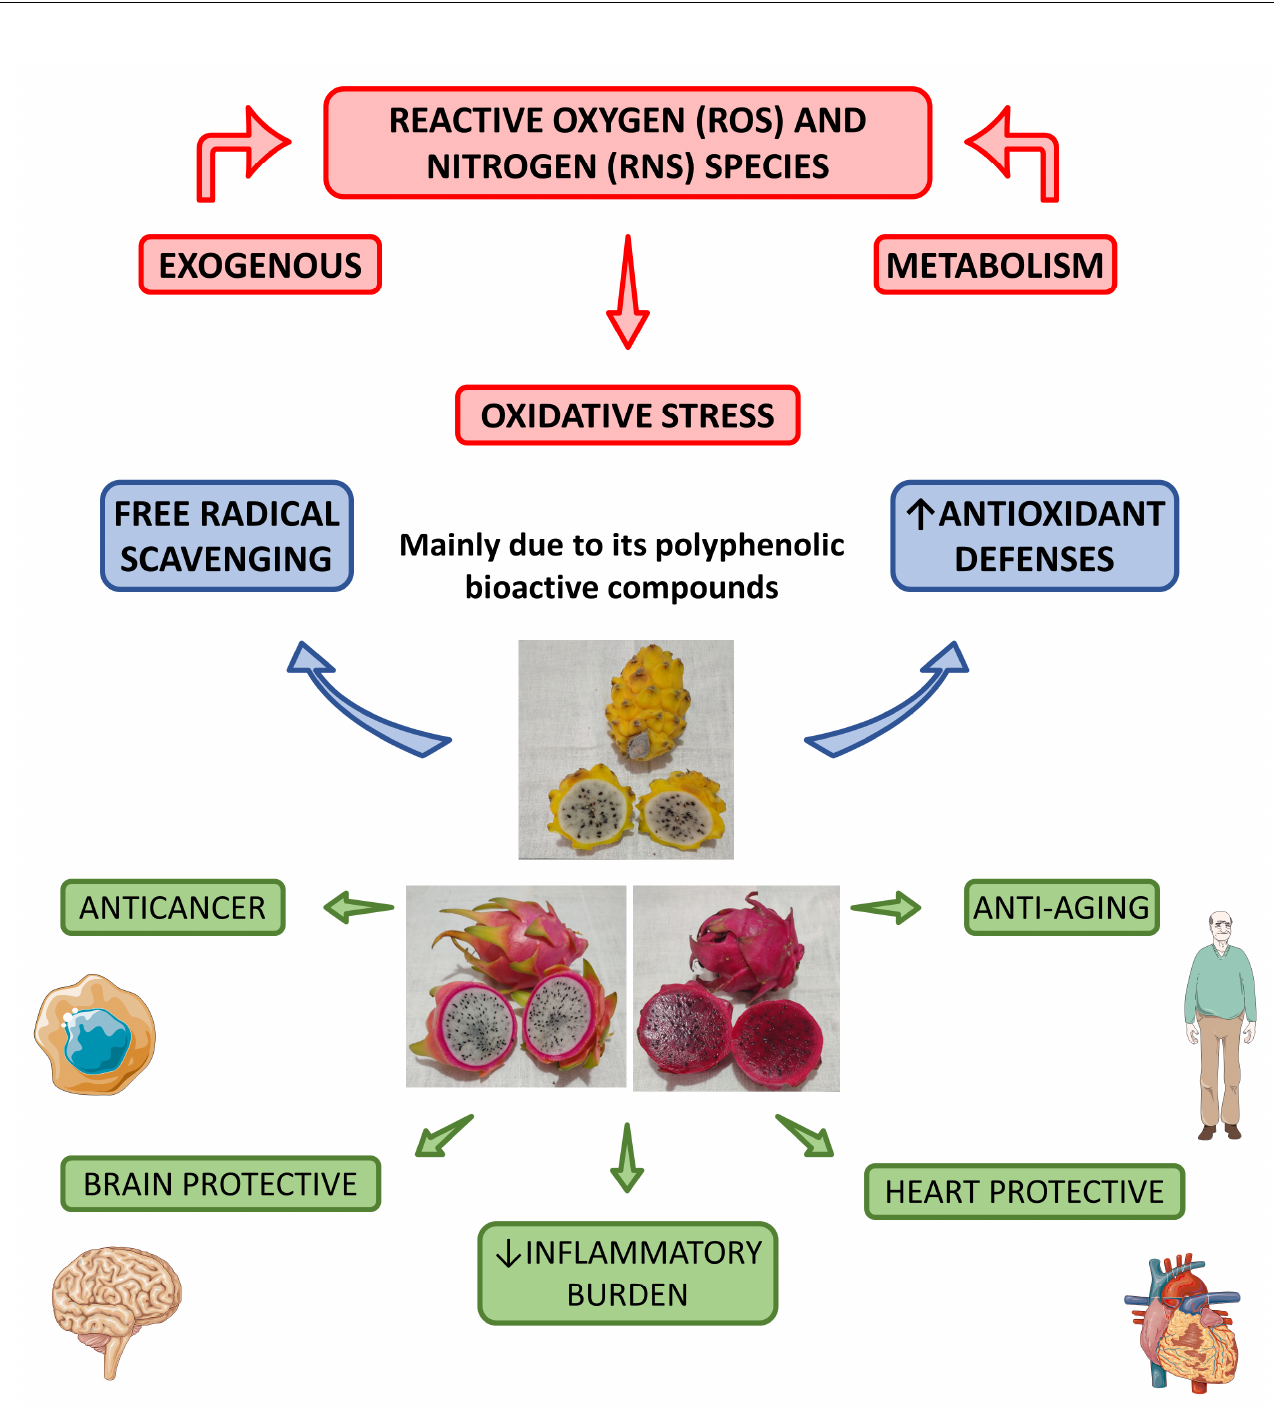
Figure 4. Main antioxidant effects of Hylocereus species and their health effects. ↑ —increase; ↓ — decrease.